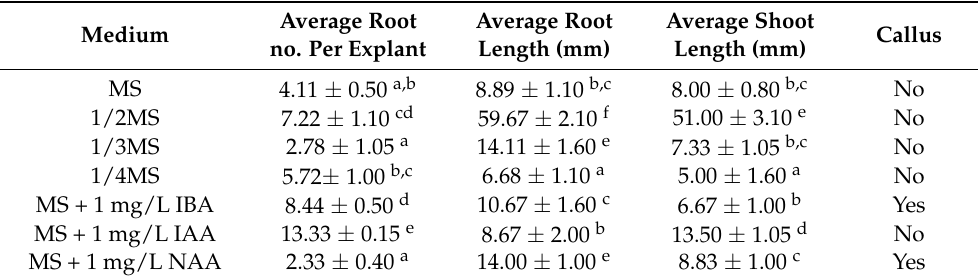
Table 4. Influence of different plant growth regulator concentrations on rooting of L. chinense shoots after six weeks of culture.